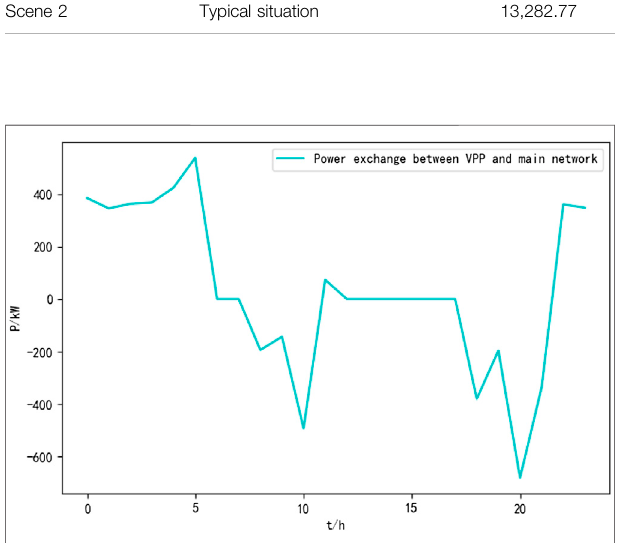
FIGURE 6 | Power interaction curve between the VPP and grid.